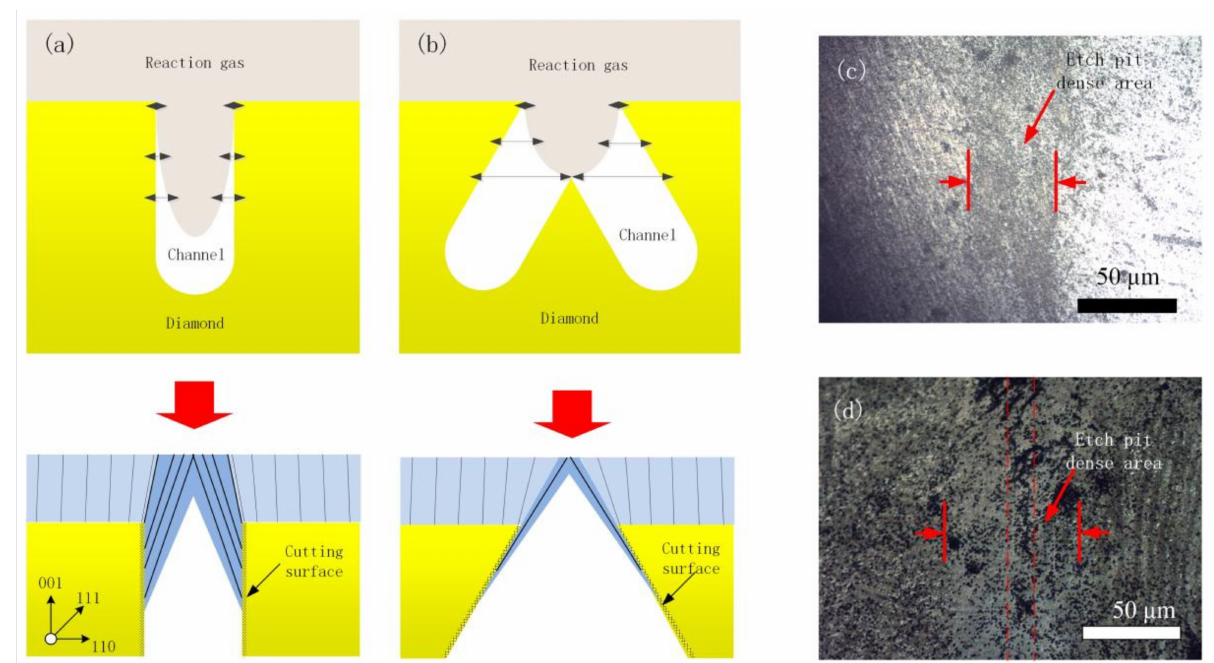
Figure 7. Two types of microchannel: ( a ) vertical trench; ( b ) reverse-V-shaped trench; ( c ) etch pit distribution of vertical trench; ( d ) etch pit distribution of reverse-V-shaped